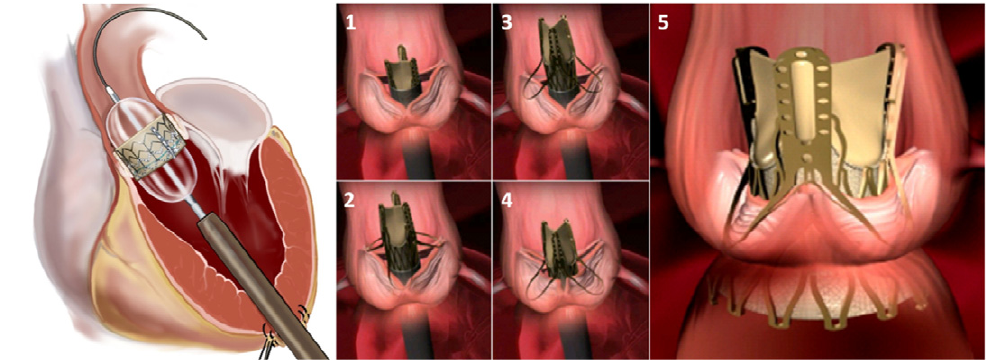
Figure. 1 Left: Transapical implantation of balloon-expanded T-AVI valve (schematic), Right: Transapical implantation of self-expanding T-AVI valve